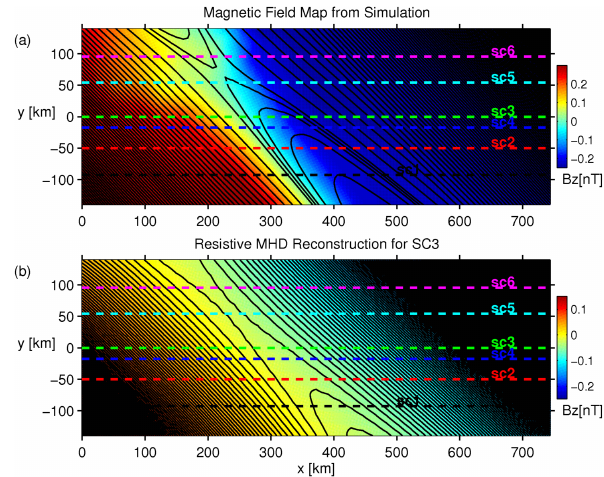
B across the layer, which is not 578 z B in 581 z